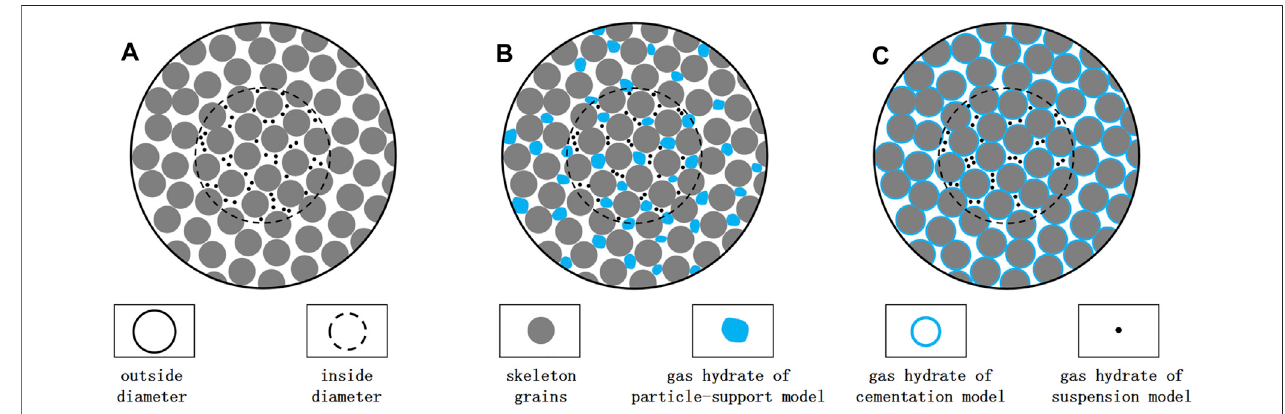
FIGURE 1 | Schematic diagram of hydrate occurrence modes. In (A-C) , suspension mode hydrate is part of fl uid and distributed in the inner diameter. In (B) , particle-contact mode hydrate becomes part of solid frame. In (C) , cemented mode hydrate cements the grains evenly.